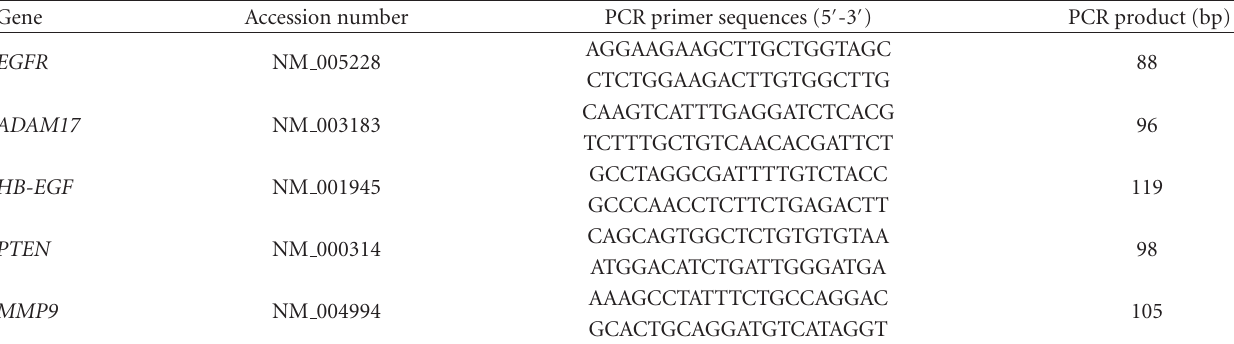
Table 5: GeneBank accession numbers, PCR primer sequences, and